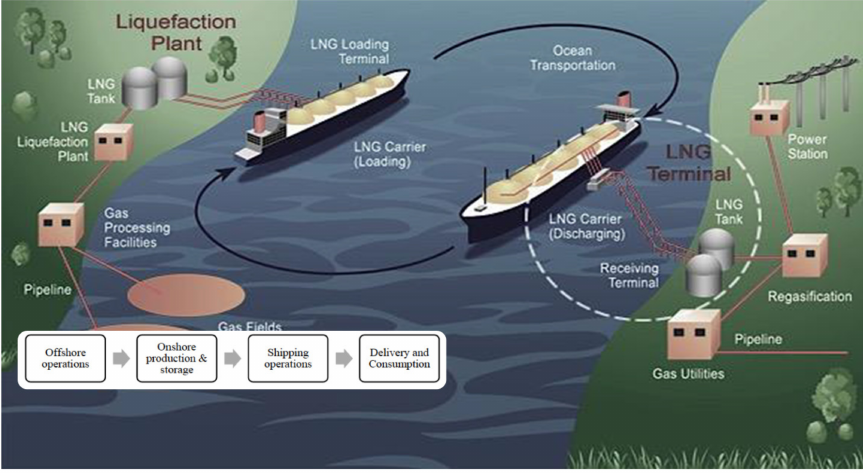
Figure 3. LNG Supply Chain [11,23].